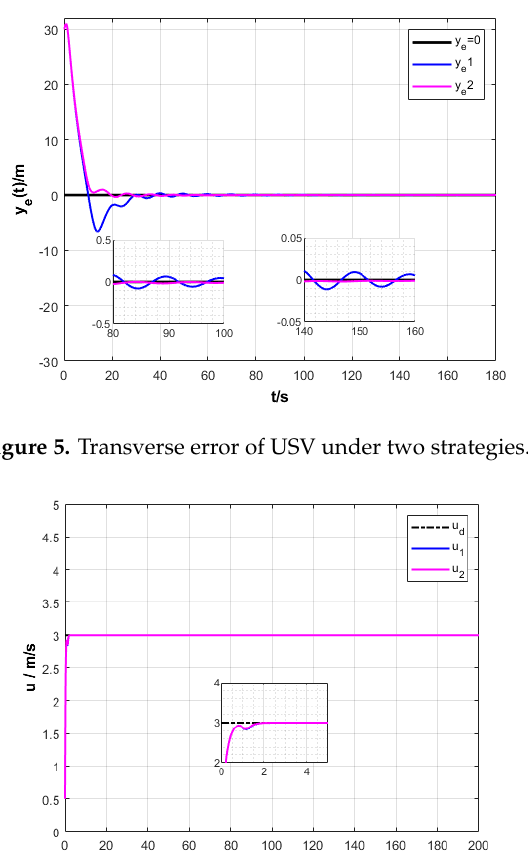
Figure 4. Straight track of USV under two strategies.